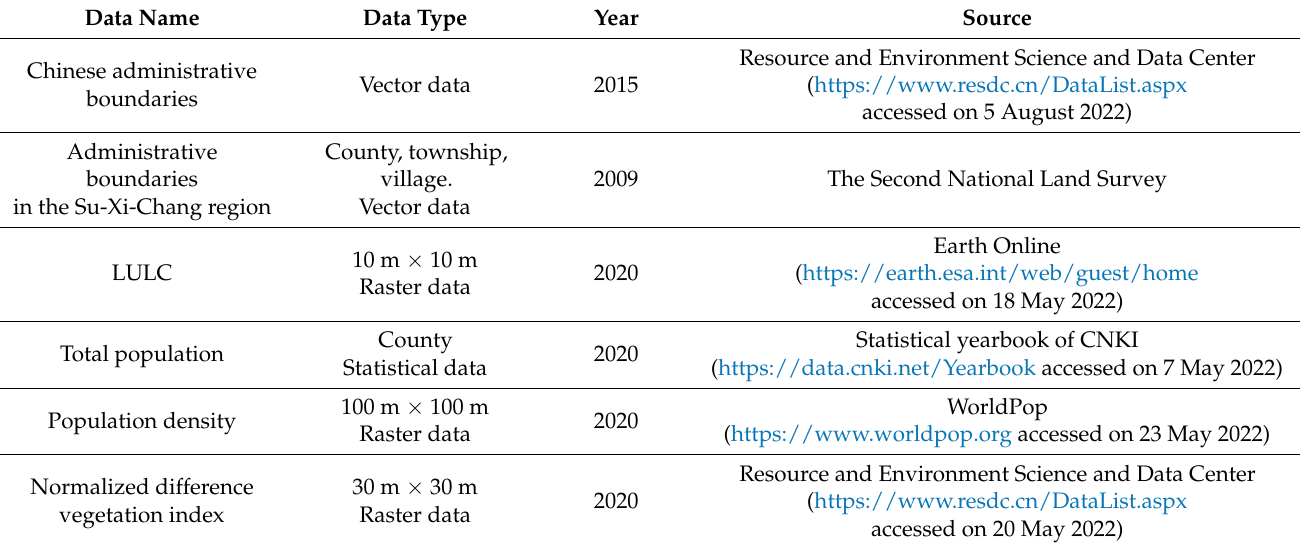
Table 1. Data used in this study.